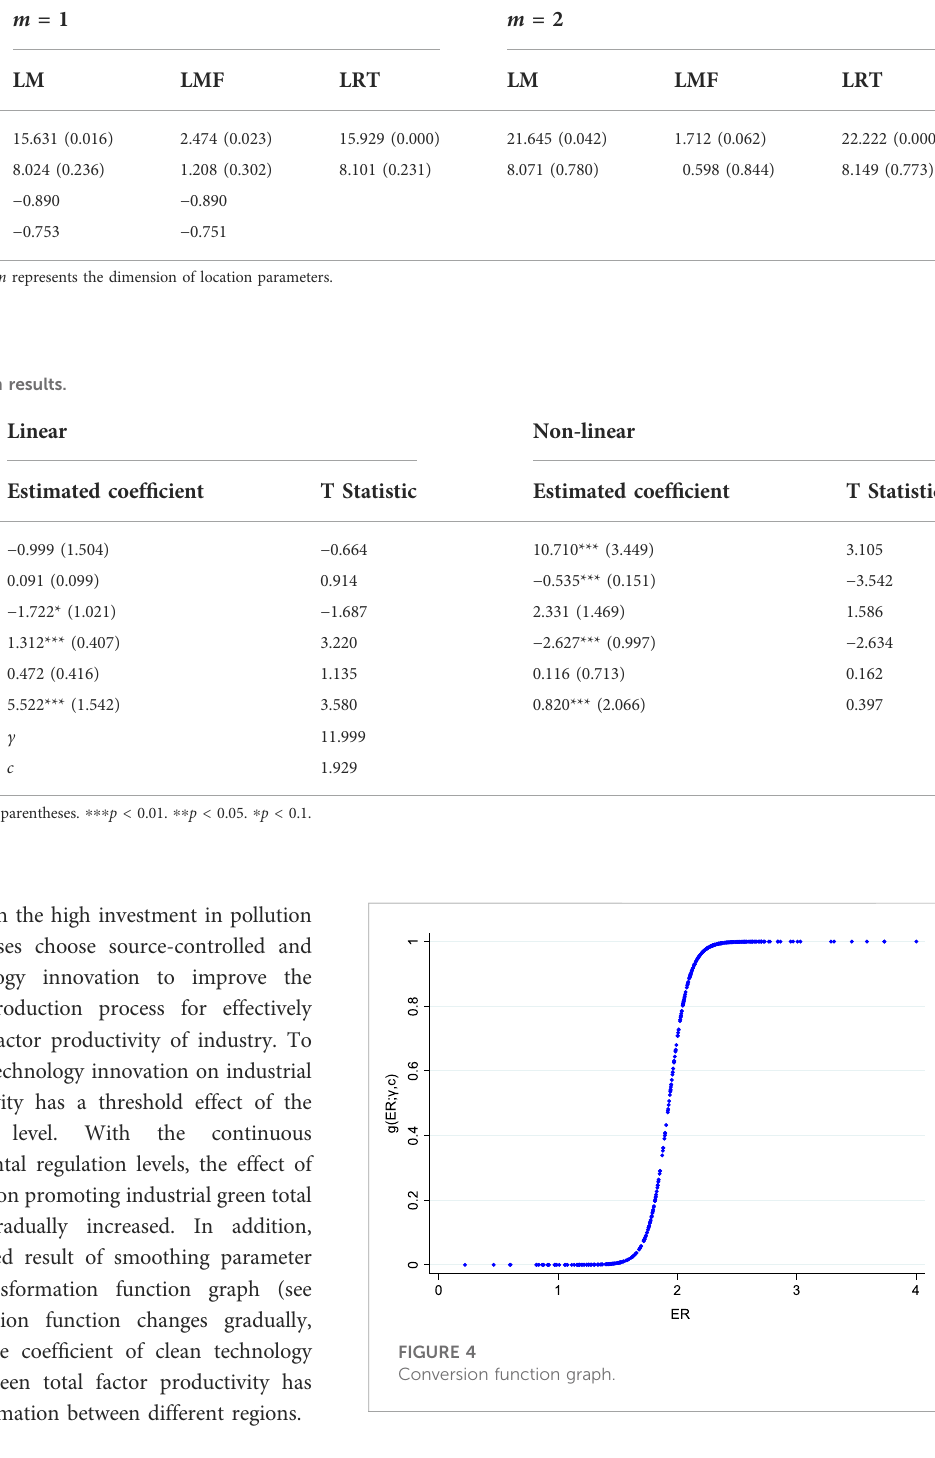
TABLE 4 Tests for remaining non-linearity.